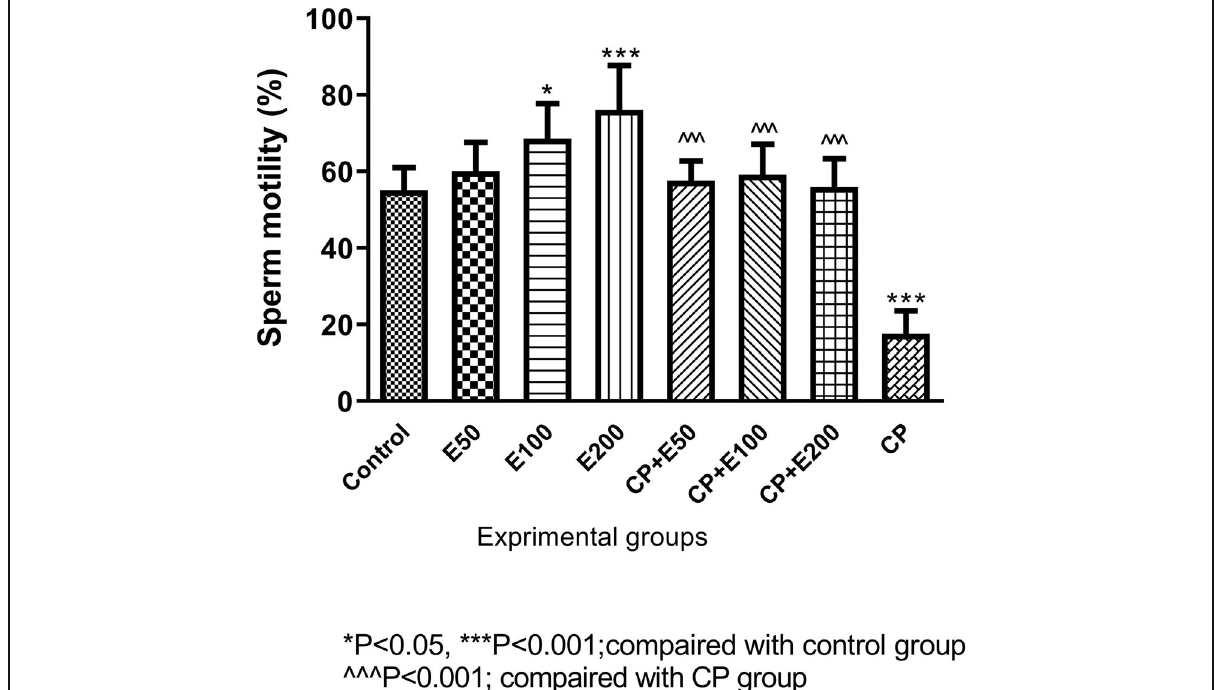
Fig. 2 The effect of Allium atroviolaceum L. extract (E) on sperm motility in cyclophosphamide (CP)-treated